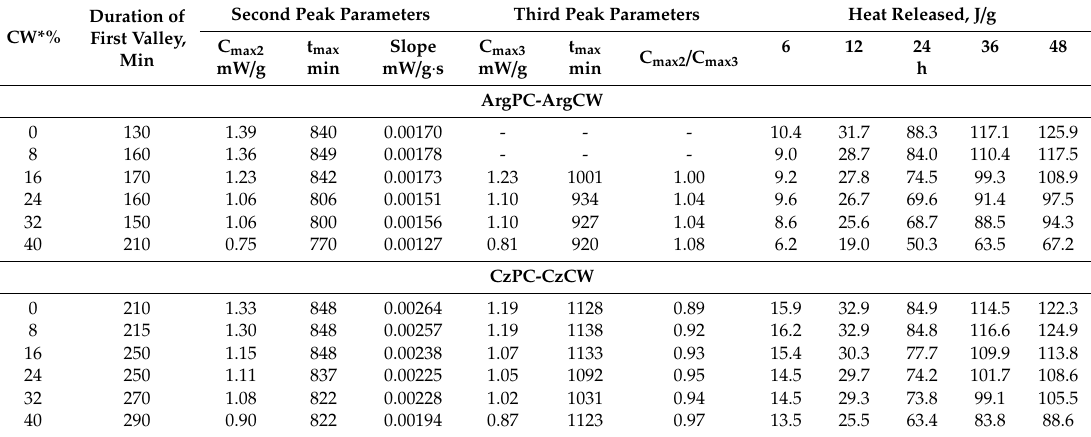
Figure 6. The heat of evolution and cumulative heat released for blended cements: ( a ) ArgPC-ArgCW; ( b ) CzPC-CzCW. Table 3. Parameters of the heat released curve and cumulative heat released for all blended cement.